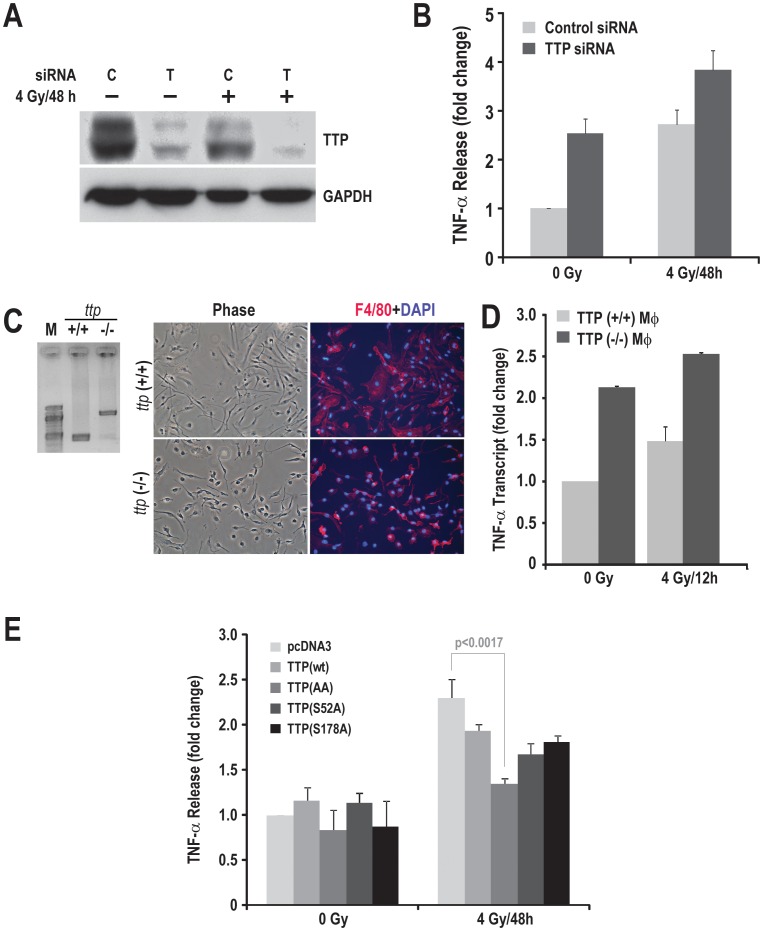
Tristetraprolin negatively regulates radiation-induced TNF-α production.(A) MH-S cells were treated with either control (C) or TTP (T) siRNA and 24 h post-transfection cells were left un-irradiated or irradiated with 4 Gy. Cell lysates were prepared 48 h post-radiation and immunoblotted with the indicated antibodies. (B) TNF-α levels secreted in the culture supernatant were quantitated on the above mentioned samples and represented as fold change considering the sham irradiated control siRNA-treated sample as 1. (C) Bone marrow from ttp (+/+) and ttp (−/−) mice were isolated and differentiated into macrophages as described in the materials and methods. Left panel shows the PCR based genotyping of the mice used in the study and the right panel confirms macrophage differentiation using F4/80 immunofluorescence staining. (D) Bone marrow derived macrophages were either sham irradiated or radiated with 4 Gy. 12 h post-irradiation RNA samples were isolated and TNF-α transcript levels were quantitated as described in materials and methods. (E) MH-S cells were transfected with either vector control DNA or with various TTP constructs (WT, Ser52Ala, Ser178Ala, and Ser52/178Ala). 24 h post-transfection, cells were exposed to 4 Gy, and TNF-α secretion was quantified in culture supernatant 48 h post-radiation.